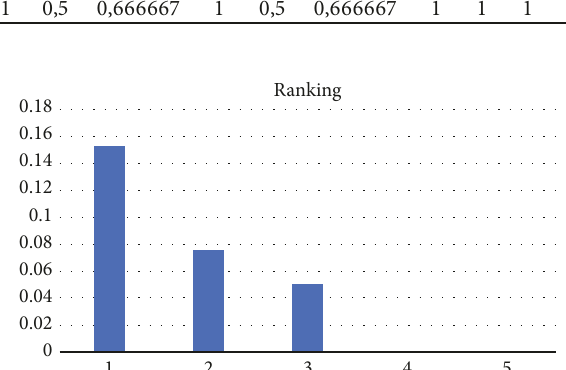
Table 8: Criteria weight value, the result of calculation which contains the weight value of each criterion. Figure 3: Ranking graph: ranking is derived from the result of alternate weight matrix by weight of